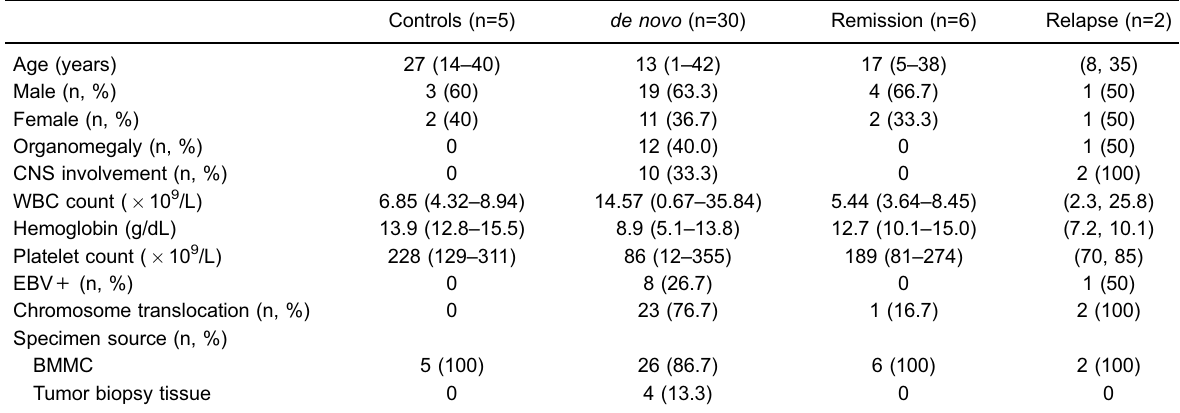
Table 1. Clinical characteristics of unaffected individuals (controls) and Burkitt lymphoma (BL)